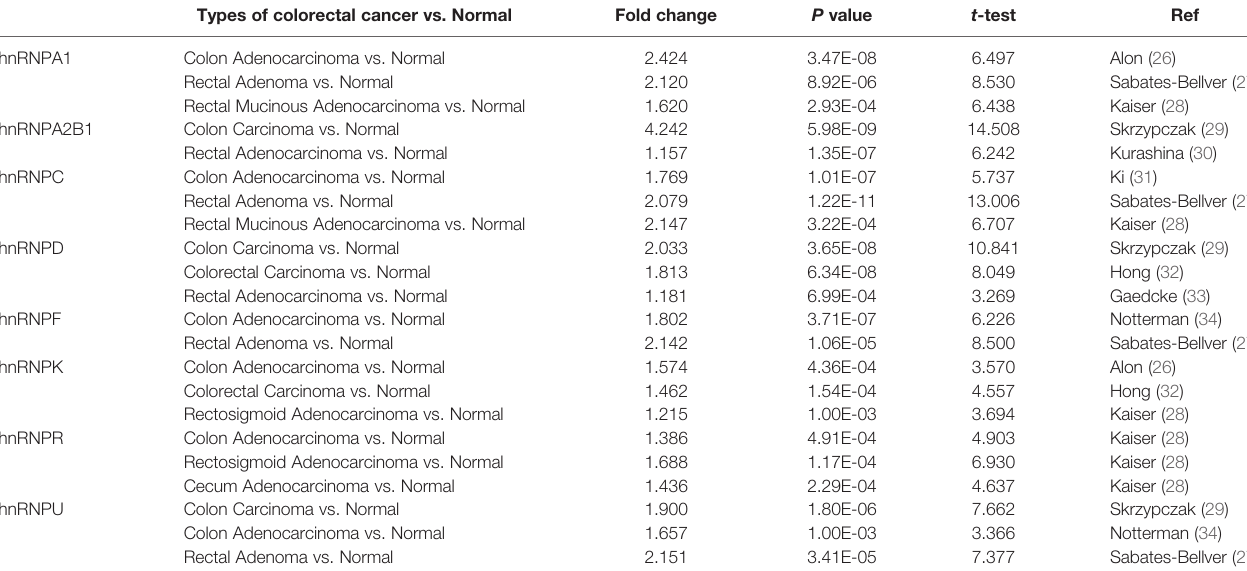
TABLE 1 | The changes of hnRNPs expression between diverse types of colorectal cancer and colorectal tissues (ONCOMINE webtool). Types of colorectal cancer vs. Normal Fold change P value t -test Ref hnRNPA1 Colon Adenocarcinoma vs.